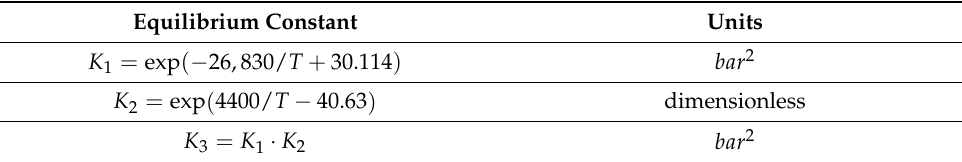
Table 2. SMR reaction equilibrium constants. Equilibrium